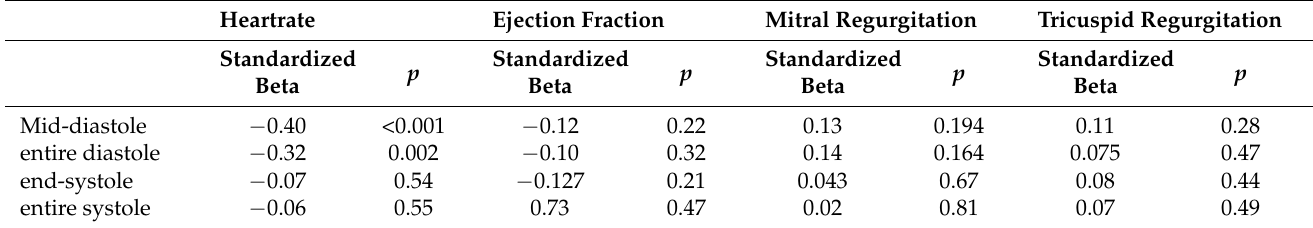
Table 3. Linear regression of factors influencing image